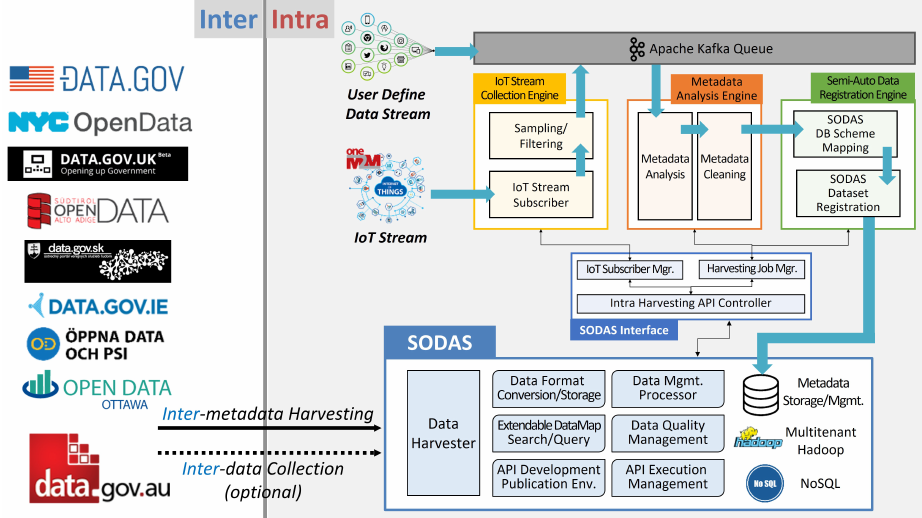
Figure 8. Harvesting operation of DataMap